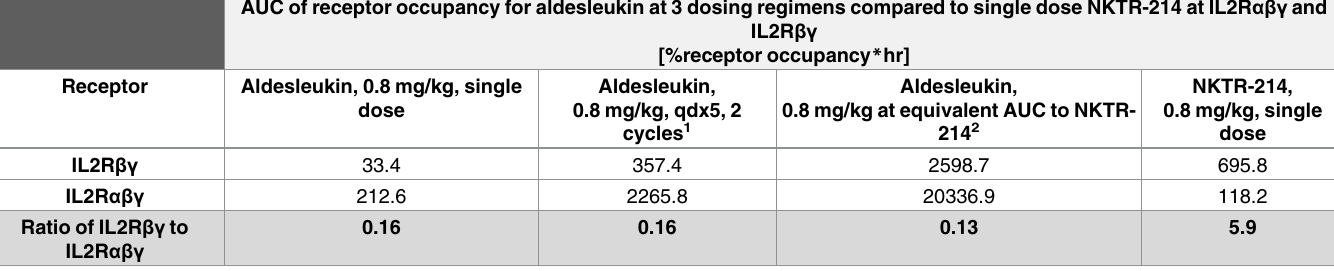
Table 5. Aldesleukin does not achieve a bias in receptor occupancy, regardless of dose or exposure. Receptor occupancy of a singledose of NKTR- 214 comparedto severaldosing regimens of aldesleukin, includinga theoretical sustainedrelease formulation that providesthe same measuredAUC as NKTR-214. The values are normalized to the AUC of aldesleukin singledose for each receptor complex.